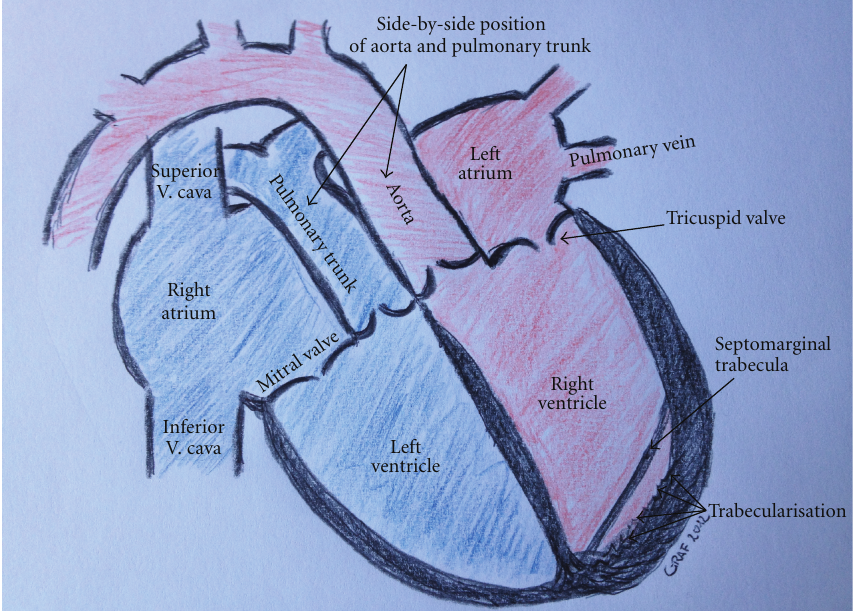
Figure 4: A schematic overview of the anatomical structures in this case of L-TGA is given.